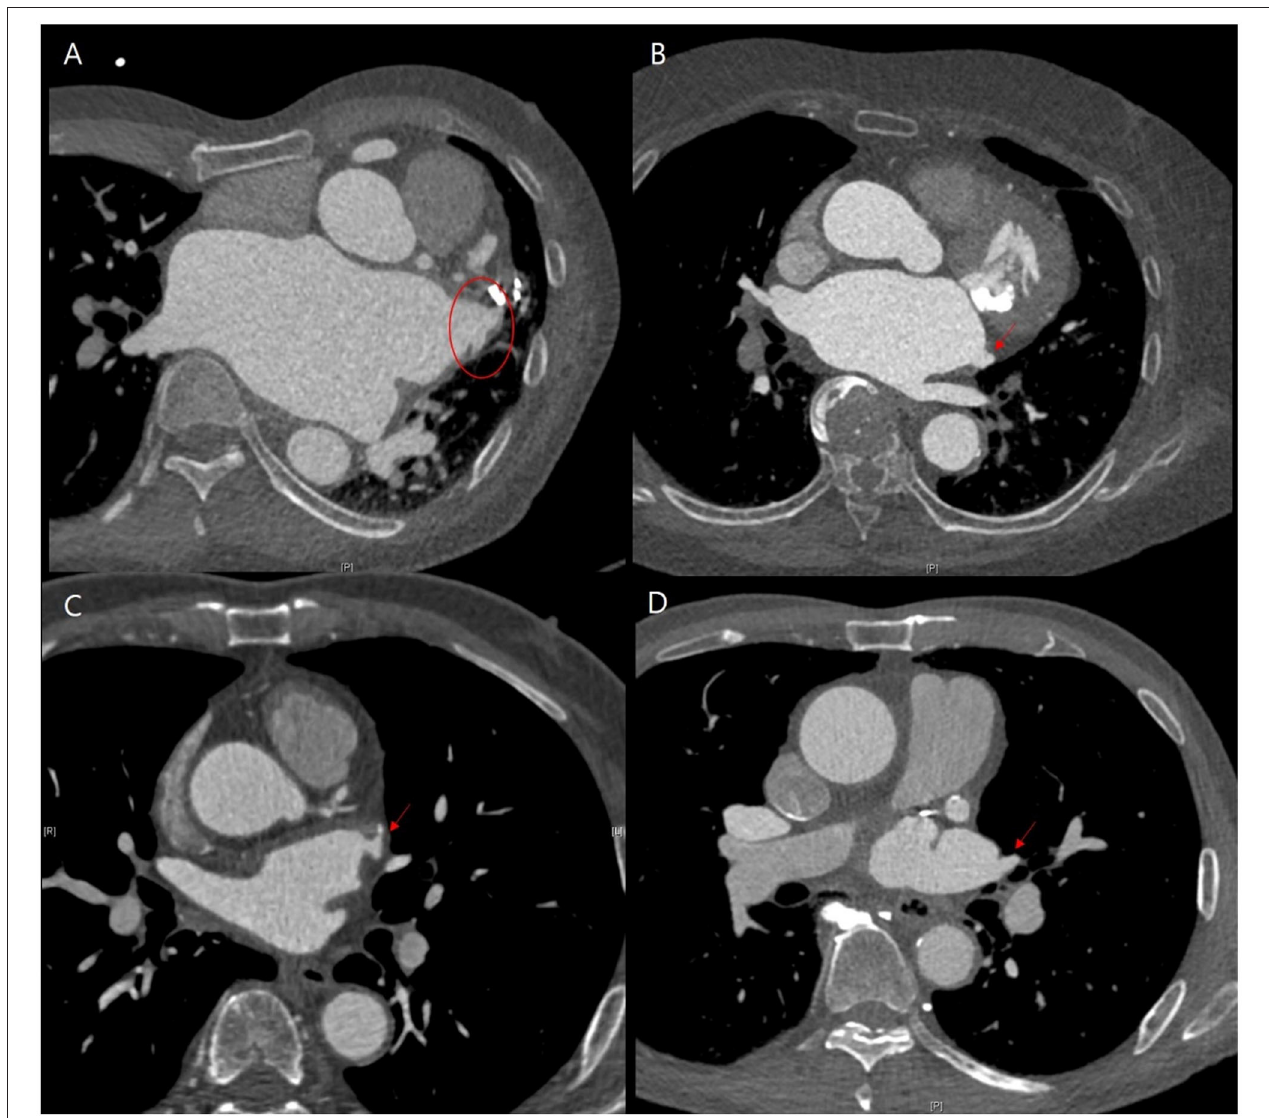
FIGURE 4 | Representative cases of follow-up computed tomography (CT) findings that showed residual left atrial appendage (LAA). (A,B) Patients exhibited the occurrence of ischemic stroke, while (C,D) did not. (A) Residual trabeculated LAA. (B) Left atrial accessory appendage and mitral annular calcification without functional mitral stenosis. (C,D) Remnant LAA